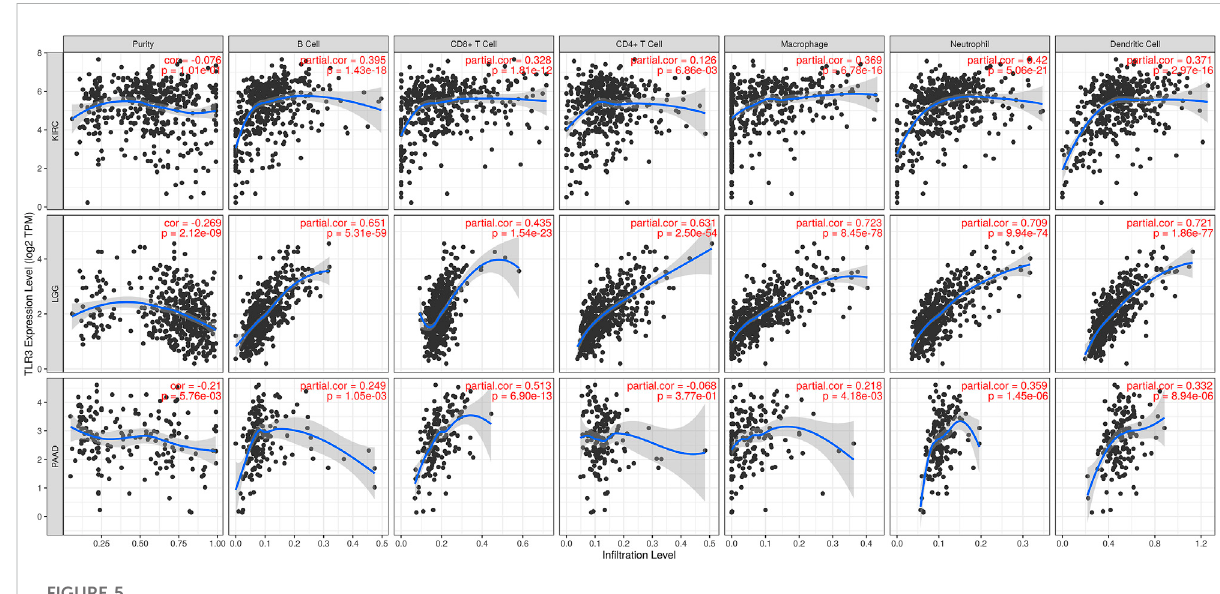
FIGURE 5 Associations of TLR3 expression with in fi ltration levels of immune cells in KIRC, LGG and